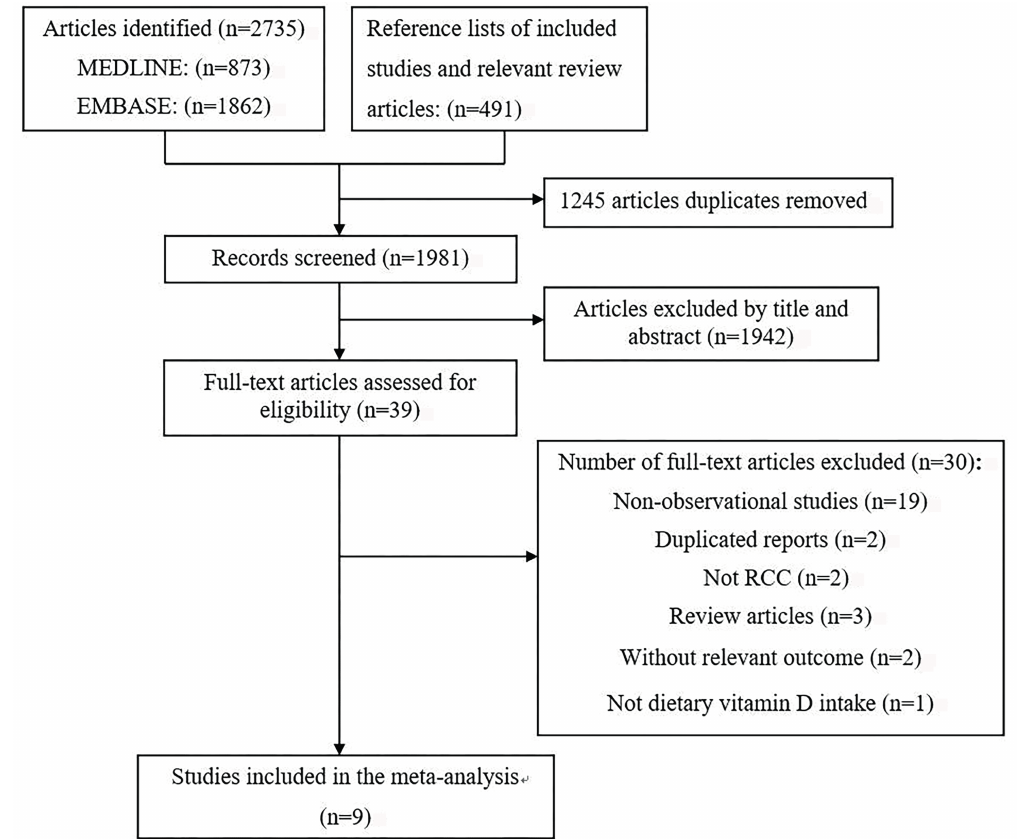
Figure 1 - Flow diagram of literature searching and